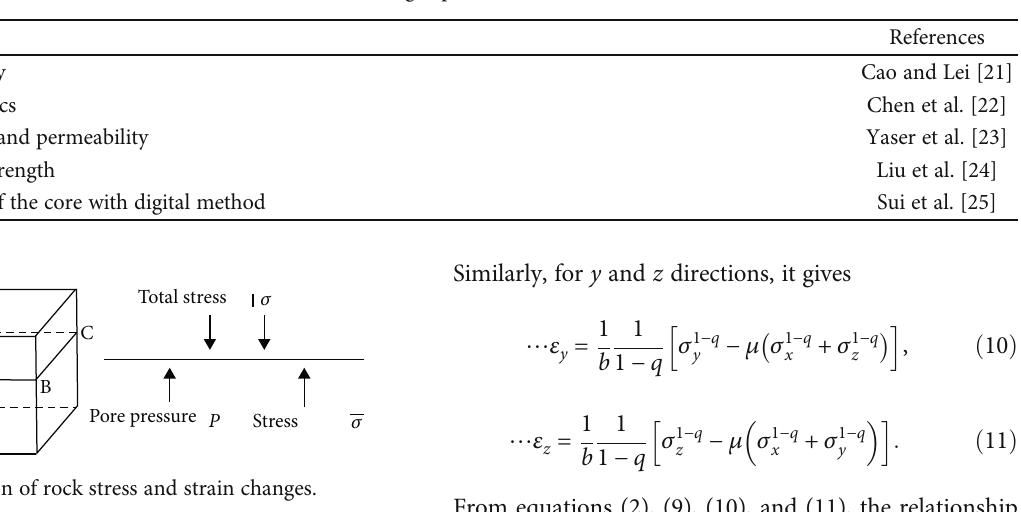
Table 1: Existing experiment.